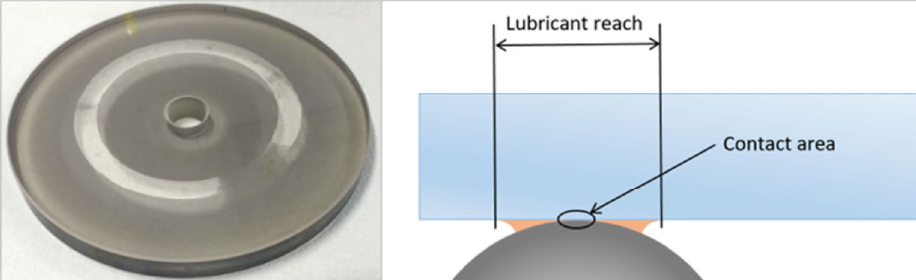
Fig. 6 (a) Damaged chromium layer of glass disc after ionic liquid excitation and (b) schematic of the scar width developed along the reach of the charged